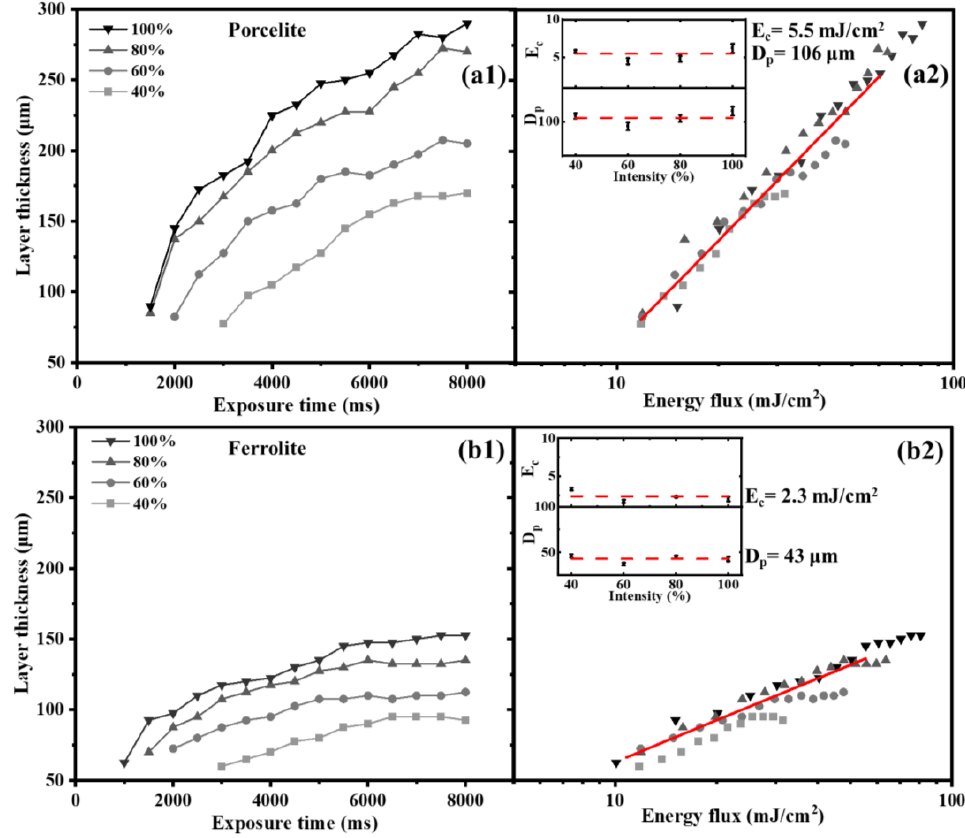
Figure 5. Monolayer film thickness as a function of exposure time at different light intensities ( a1 , b1 ) and as a function of radiated energy flux ( a2 , b2 ), for determination of critical energy (E c ) and penetration depth (D p ) of pure suspensions: Porcelite ( a1 , a2 ) and Ferrolite (+1% TPO) ( b1 , b2 ).